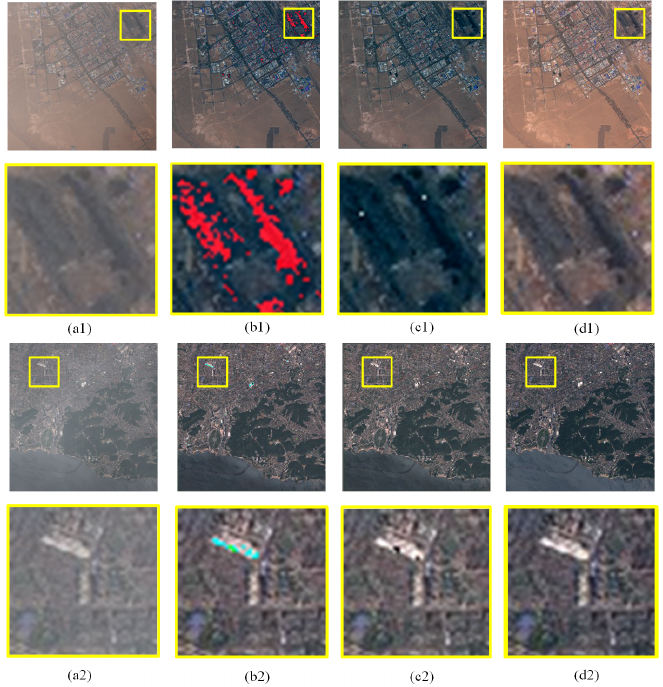
Figure 8. The thin cloud removal results of two Sentinel-2A samples reconstructed in different color spaces: ( a1 , a2 ) input cloudy image, ( b1 , b2 ) output images reconstructed in YUV color space, ( c1 , c2 ) output images reconstructed in YUV color space, and ( d1 , d2 ) reference cloud-free